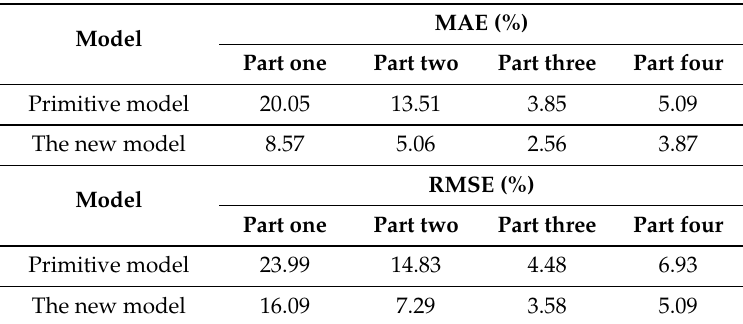
Table 1. Experimental results of two